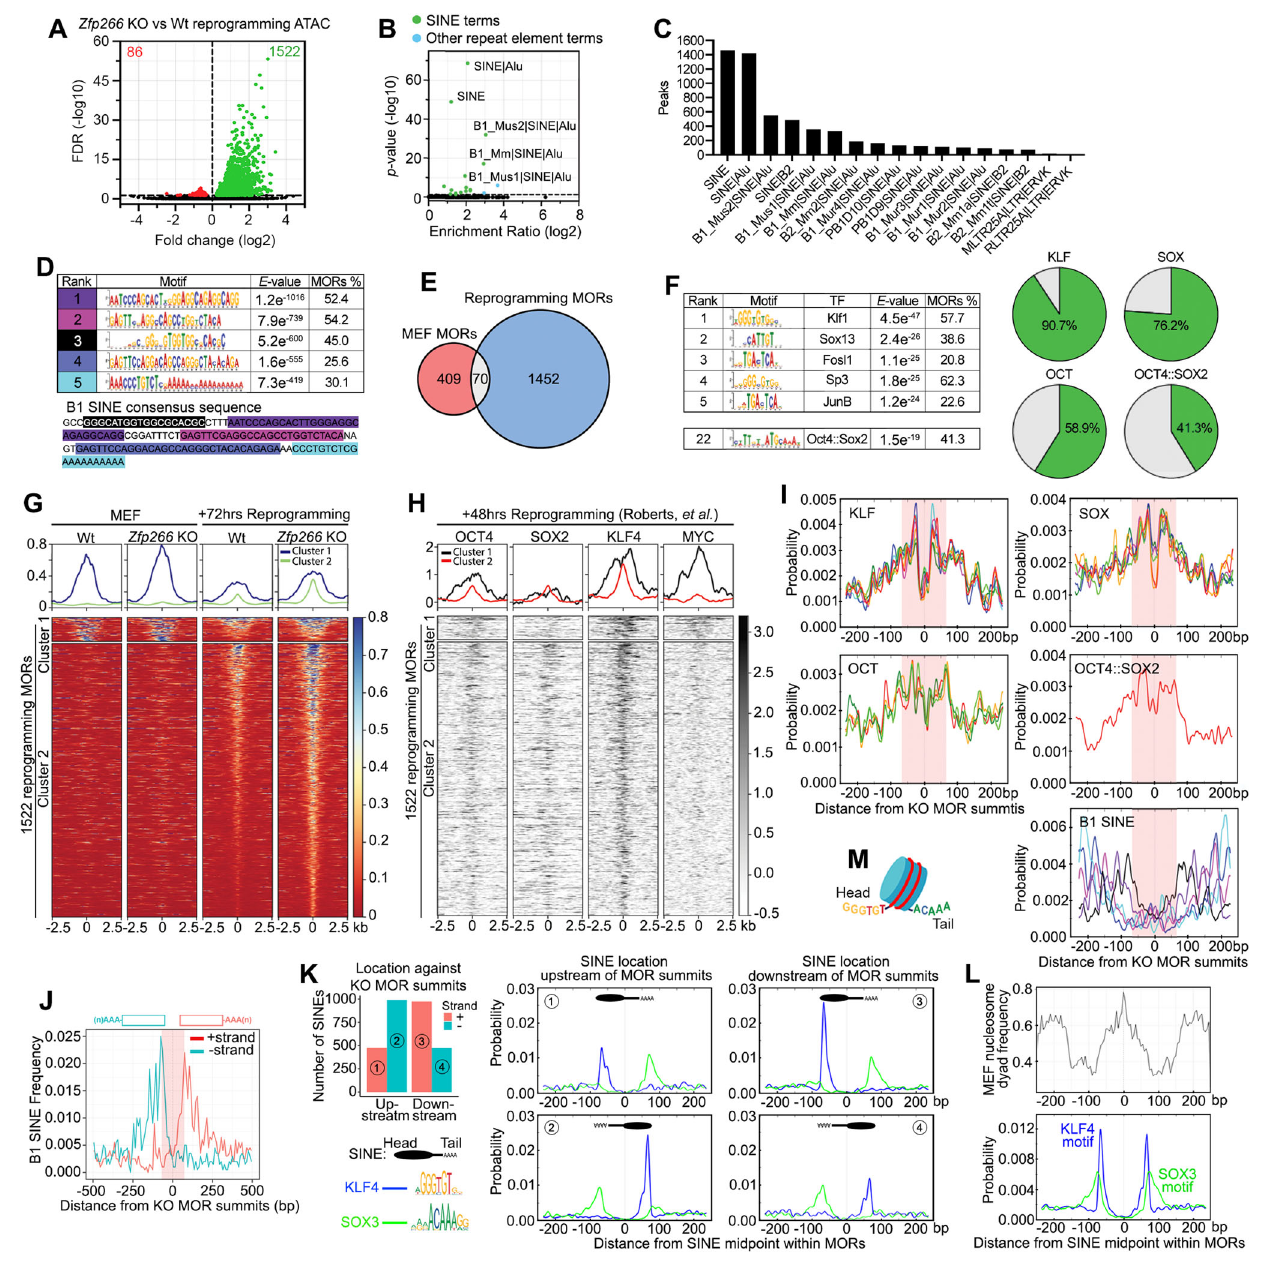
Fig. 5 | Reprogramming Zfp266 KO MEFs results in chromatin opening at OSK bound, B1 SINE containing loci. A ATAC-seq volcano plot of Zfp266 KO vs Wt reprogramming at 72h. Green and red dots indicate more open regions (MORs) and more closed regions in Zfp266 KO reprogramming, respectively (FDR<0.05). B Signi fi cance and fold enrichment ratio of transposable element (TE) families withinZfp266KOMEFMORs.Greendotsindicatesigni fi cantlyenrichedSINEs,blue dots indicate other signi fi cantly enriched TEs. The p -values were calculated by the cumulative hypergeometric distribution. C Number of Zfp266 KO reprogramming MORs with TEs. D De novo motif discovery analysis on Zfp266 KO reprogramming MORs. The motifs correspond to parts of the B1 SINE consensus sequence are indicated by matching colors. E Overlap between Zfp266 KO MEF and Zfp266 KO reprogramming MORs. F Motif enrichment analysis with Zfp266 KO reprogram- ming MOR summits and percentages of MORs with KLF, SOX, OCT (POU) family andOCT4::SOX2motifs. G Classi fi cationof Zfp266 KOreprogrammingMORsbased